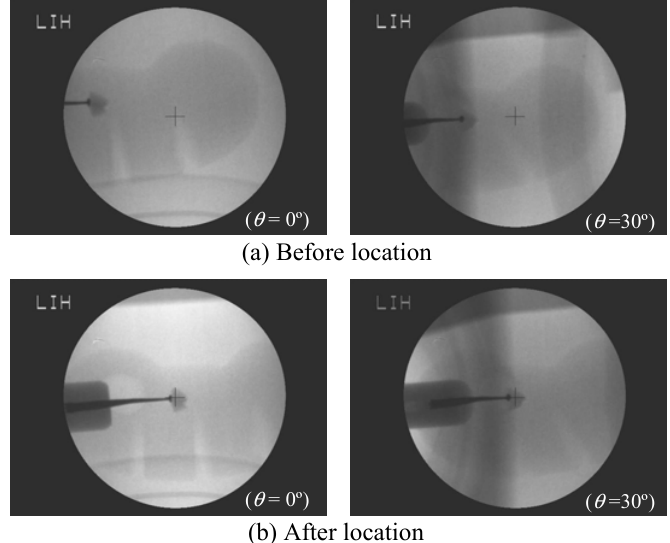
Figure 7. The fluorescent images of the phantom ( a ) before stone location, and ( b ) after stone